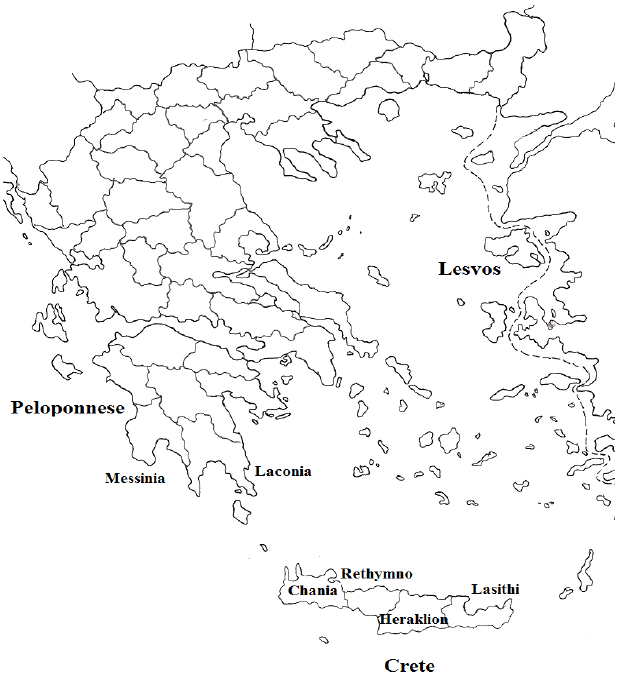
Figure 1. Map of Greece showing the geographical origin of the olive oil samples. Table 1. Rate of successful classification (%) of the olive oil samples by partial least squares discriminant analysis (PLS-DA) for all spectral regions /